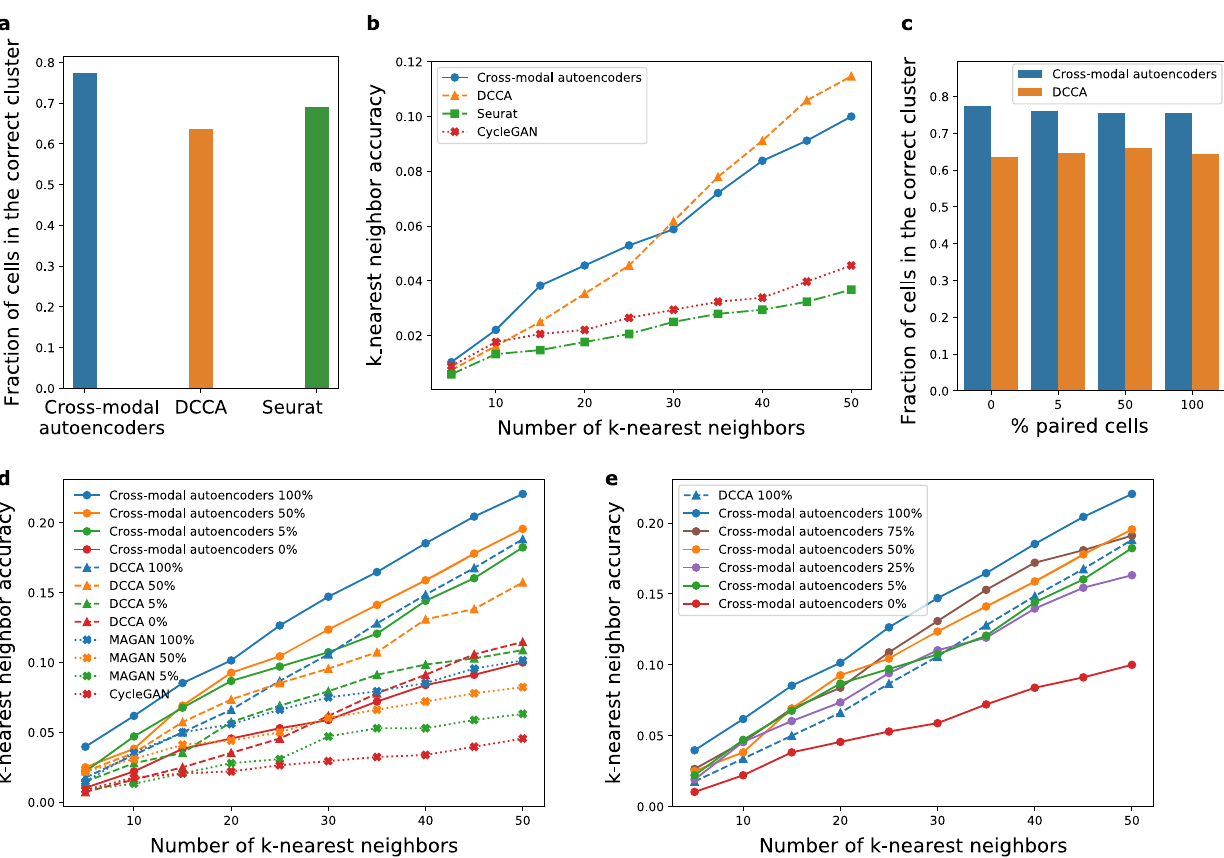
Fig. 2 Performance of our multimodal data integration method (cross-modal autoencoders), deep canonical correlation analysis (DCCA), Seurat, CycleGAN, and MAGAN on paired RNA-seq and ATAC-seq data. a Fraction of cells that were assigned to the correct treatment time cluster based on their embedding in the integrated latent space that was learned by fi tting our cross-modal autoencoder model, DCCA, or Seurat. b k -nearest neighbor accuracy for quantifying the quality of matching between local neighborhoods for our cross-modal autoencoder model, DCCA, Seurat, and CycleGAN trained with 0% supervision (no paired samples). c Fraction of cells that were assigned to the correct treatment time cluster for our cross-modal autoencoders and DCCA trained with varying amount of paired samples. d k -nearest neighbor accuracy for our cross-modal autoencoders, DCCA, MAGAN, and CycleGAN trained with 0, 5, 50, and 100% of the paired samples. e k -nearest neighbor accuracy for our cross-modal autoencoder model trained with varying amount of paired samples versus DCCA trained on all paired samples. In a – c colors denote different domain translation methods and in d – e colors denote different levels of supervision (paired samples). Additionally, different markers denote different domain translation